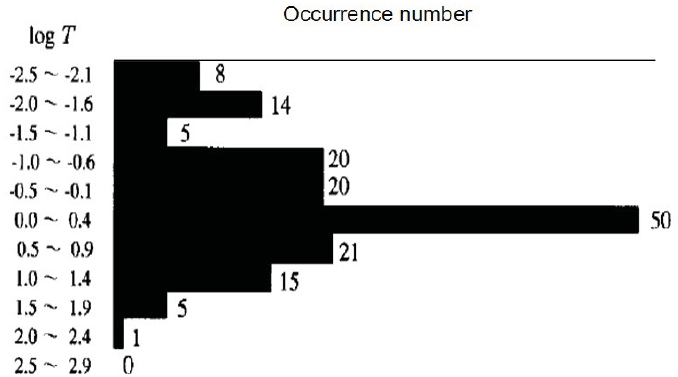
Figure 3. Occurrence histogram of time T (in units of days) of reported unusual animal behavior. Adapted from Rikitake (1998) [4] with permission of the